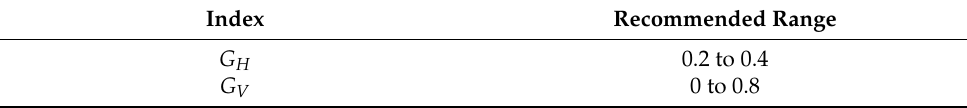
Table 2. The range recommended for G H by Renilson [7] and G V by Feldman